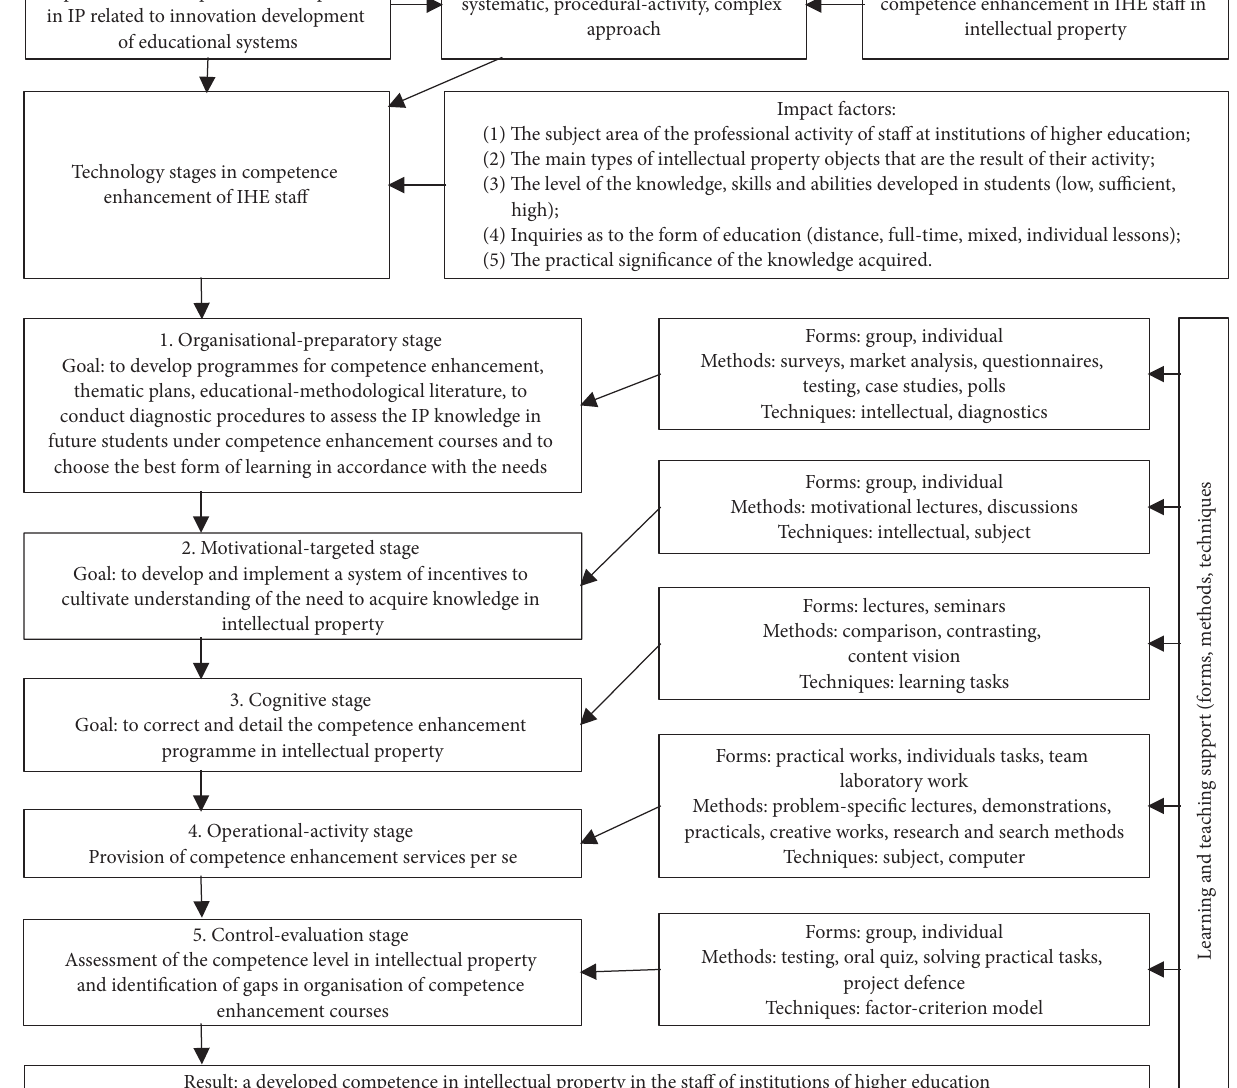
Figure 4: Model of QE technology for the IHE staff.